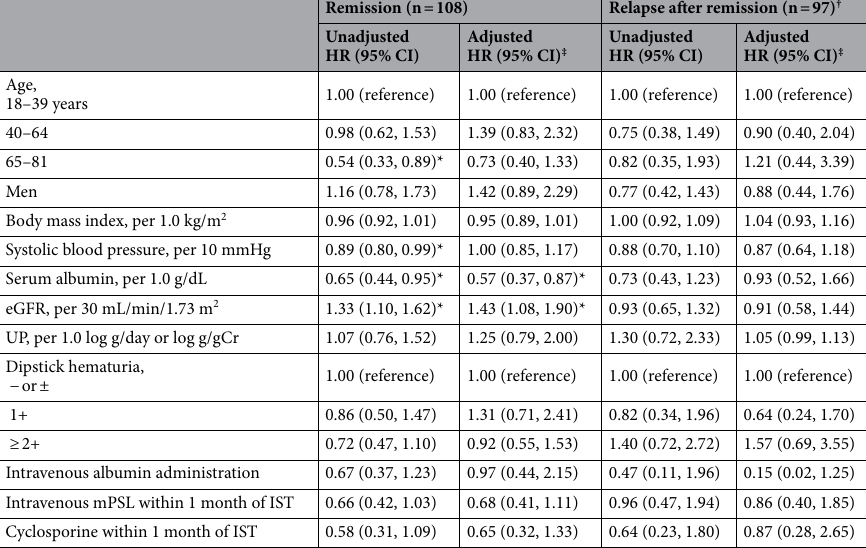
Table 2. Predictors of remission and relapse. CI confidence interval, eGFR estimated glomerular filtration rate, HR hazard ratio, mPSL methylprednisolone, UP urinary protein. *P < 0.05. † Including 97 patients with remission of proteinuria within 6 months of IST. ‡ Adjusted for all variables listed in the table.